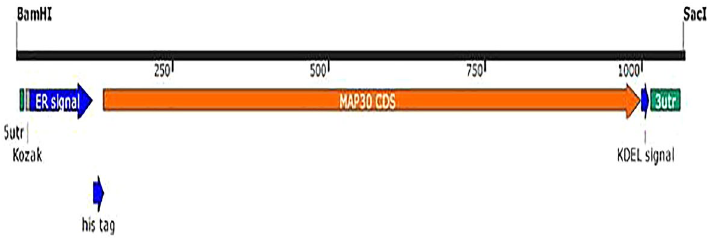
Figure 1. Expression construct of the recombinant MAP30 called pBI121–MAP30–KDEL . The nptII (kanamycin-resistance gene) under the control of the nopaline synthase ( NOS ) promoter and the codon- optimized MAP30 CDS under the control of the CaMV 35S promoter and NOS terminator were illustrated. The 6 × His tag and ER-retention signal KDEL were fused at N- and C-terminus in-frame with the MAP30 CDS,